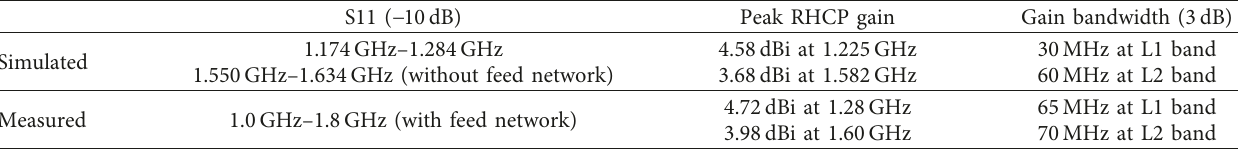
Table 2: Comparisons between the simulated and measured results.